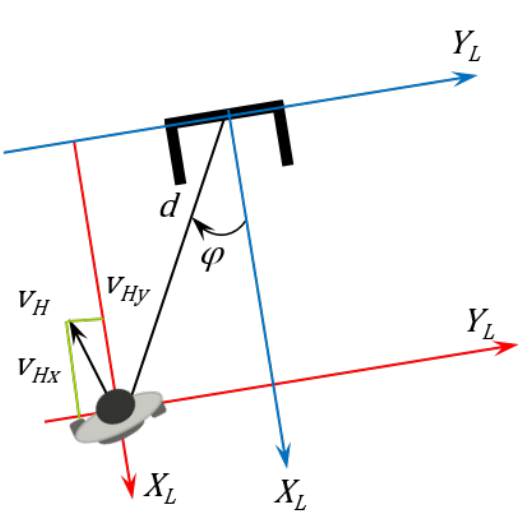
Figure 12. Human speed vector calculation.